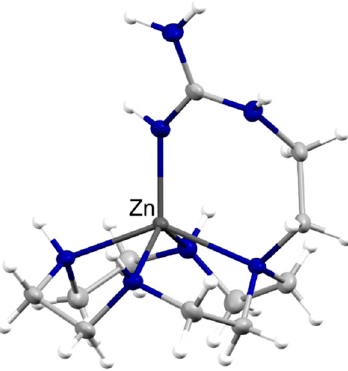
Figure 4. Arginine can be a good ligand to Zn(II). Thermal ellipsoid plot at 50% probability of a Zn(II) complex of the ligand (2-guanidinyl)ethyl-cyclen (CSD code XIZZOV). The complex was formed in an aqueous solution at neutral pH. The two perchlorate anions have been omitted for clarity. The zinc atom is labeled, whereas the nitrogen atoms are depicted in blue.